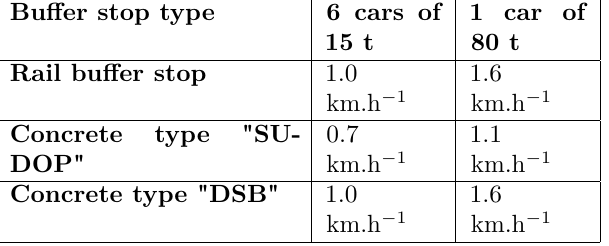
Table 1. Resistances of buffer stops used in Czech Republic [2].